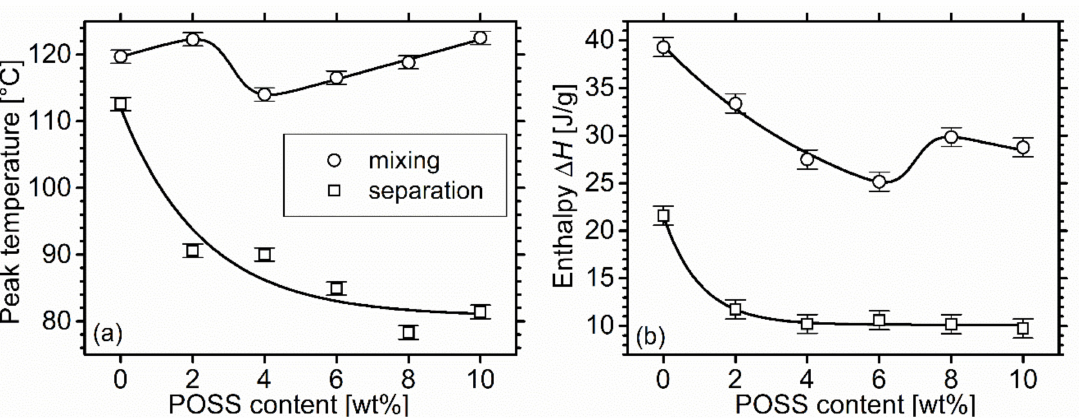
Figure 7. ( a ) Peak temperature and ( b ) enthalpy of microphase mixing and separation, during cooling and heating, respectively. Lines are guides to the eye.